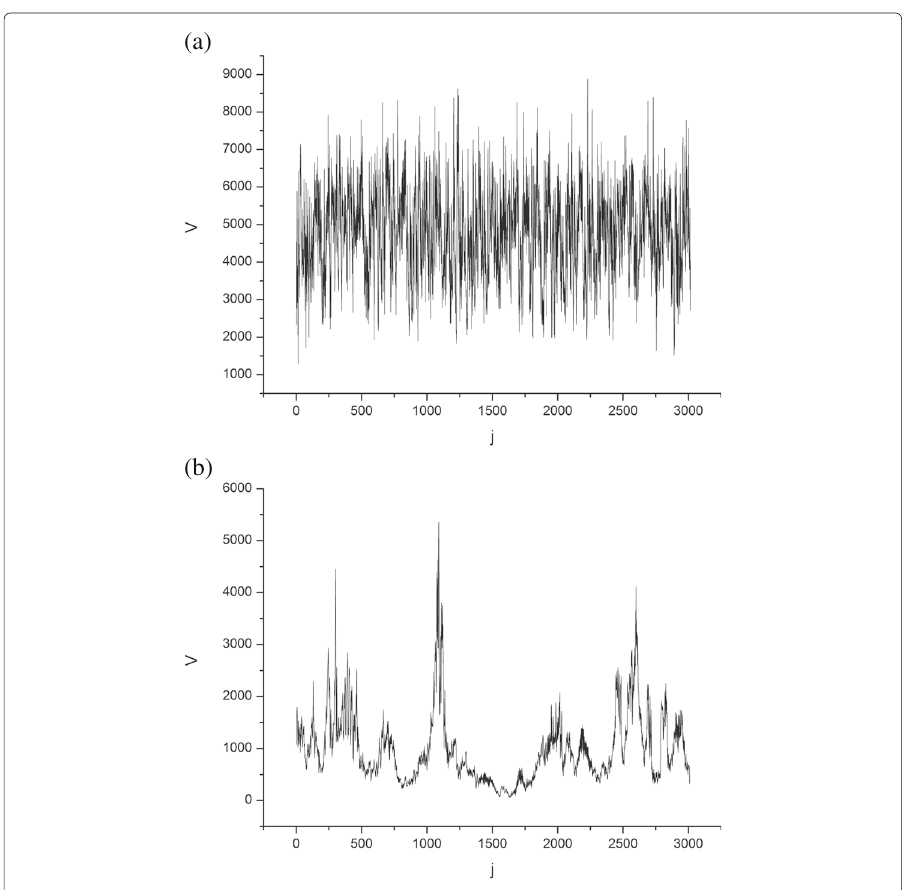
Fig. 2 Variance fluctuation series with 3,000 points obtained from 30 s audio files: a Unidos da Tijuca’s Samba-Theme - Rio de Janeiro Carnival Party - year 2012 and b J. S. Bach - Cantate BWV 156 - Ich Steh Mit Einem Fuss. Source: Author a Percussive series b Symphonic